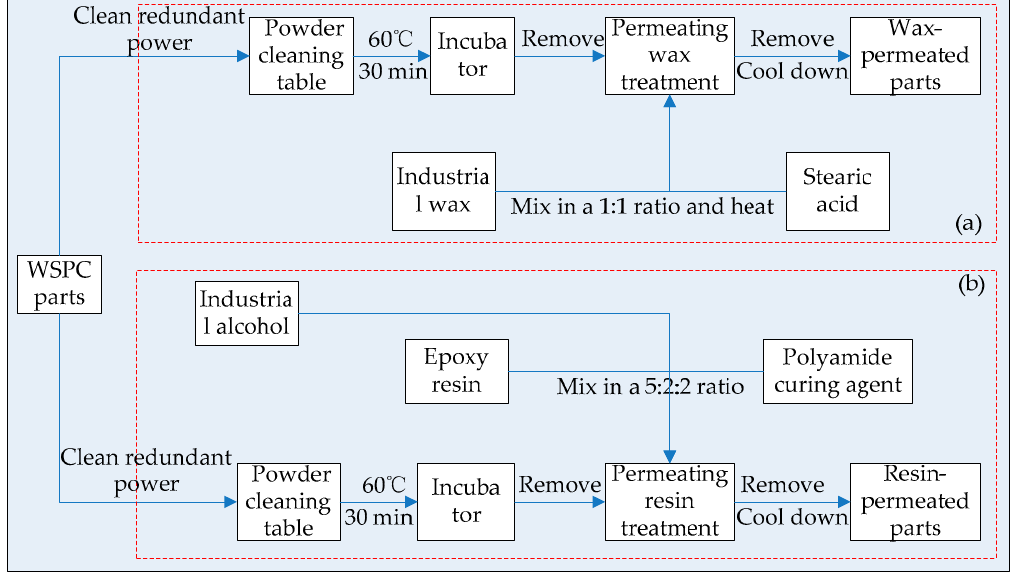
Figure 3. The post processing flow chart of WSPC parts: ( a ) permeating wax technology; and ( b ) permeating resin technology.